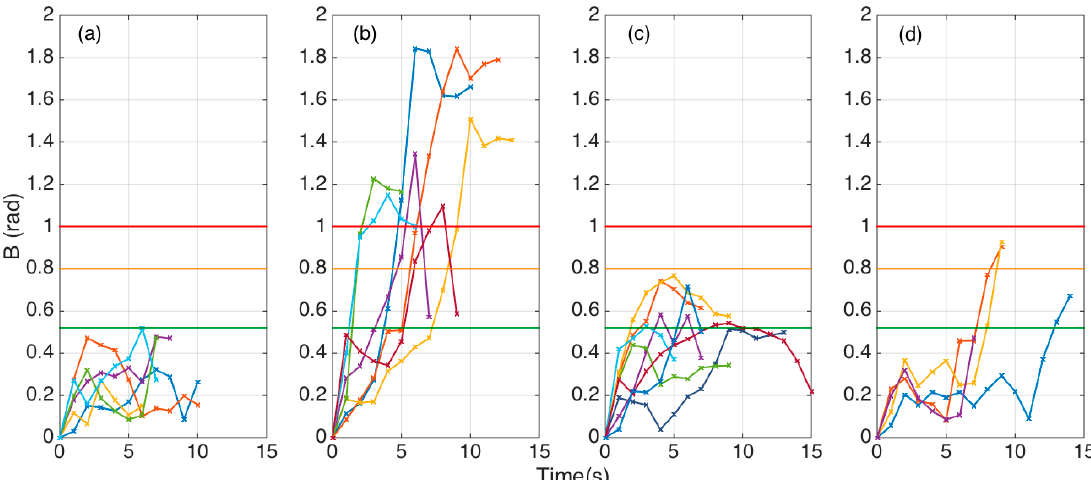
Figure 10. SPBA temporal patterns for all epidural insertions into the phantom. The charts shows the variations of B over the whole experiment duration for 25 insertions, divided into each class. Each B ( t ) trace is represented with a different color. The vertical axis shows the threshold levels for determining each type of insertion: B = 0.52 (green), B = 0.8 (orange), B = 1.0 (red). ( a ) Experiments showing a straight insertion ( n = 6). ( b ) Insertions showing a tight needle curvature that progresses through the target epidural space ( n = 7). ( c ) Hard penetrations showing bending that straightens through the insertions ( n = 8). ( d ) Failed insertions characterized by a strong deflection towards reaching the target zone ( n = 4).